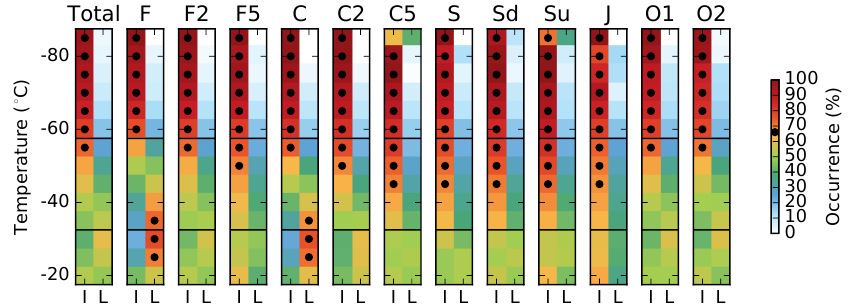
Figure 4. The probability of finding liquid- or ice-origin cirrus for each of the regimes over a north Atlantic region during 2007. The cirrus origin is from the dataset in Wernli et al. (2016), with “I” indicating “in situ” origin and “L” indicating liquid origin. The plots are normalised such that the probabilities sum to one for each regime and temperature. The dots indicate more than two-thirds of clouds assigned to either liquid or in situ origin